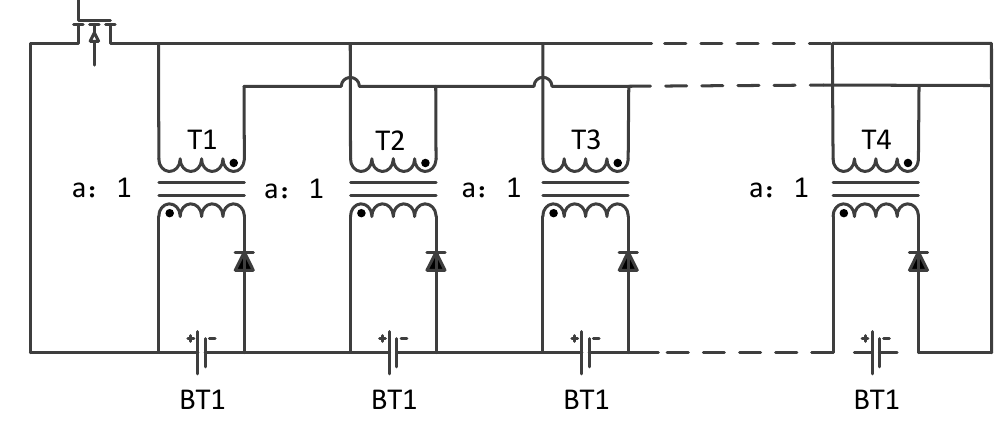
Figure 6. Principle of multi-transformer balance.